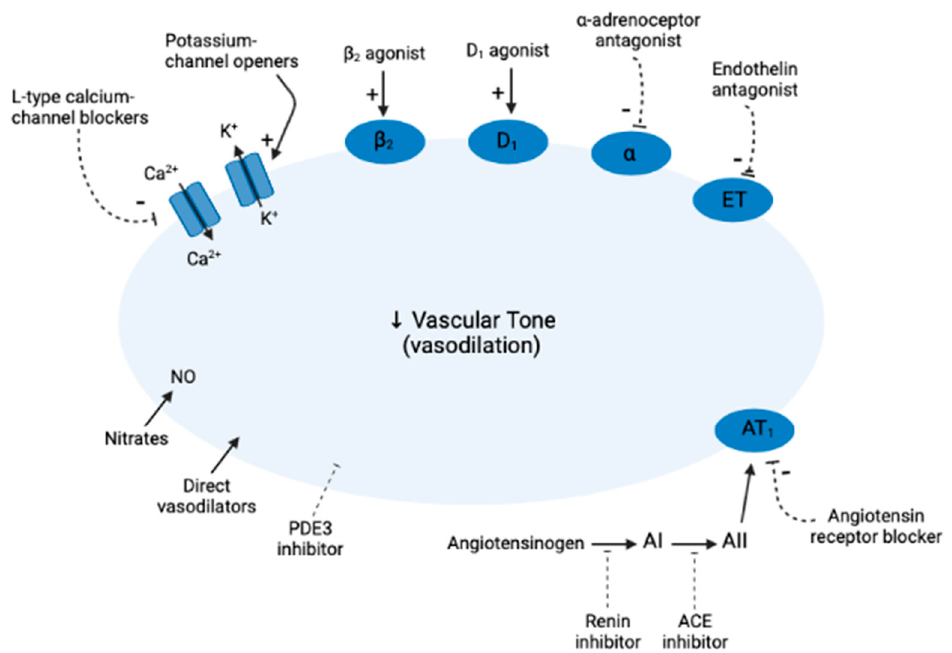
Figure 1. General mechanisms of action of vasodilators. Vasodilators may activate receptors that open potassium channels, produce hyperpolarization of the endothelium, and enhance calcium influx through receptor-operated calcium channels. Stimulation of β 2 and D 1 receptors causes smooth muscle relaxion, while α -adrenoceptor antagonists, endothelin antagonists, and angiotensin receptor blockers prevent the binding of norepinephrine, endothelin, and angiotensin II, respectively. Nitrates increase the amount of NO in vascular tone, causing vasodilation. PCE3 inhibitors prevent the phosphodiesterase enzymes from breaking down cAMP and cGMP in the cell, causing vasodilation and smooth muscle relaxation. The exact mechanism of direct vasodilators is still